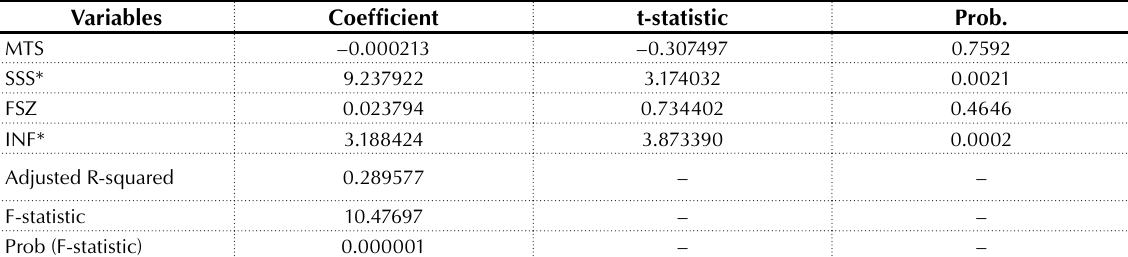
Table 3. Panel data regression